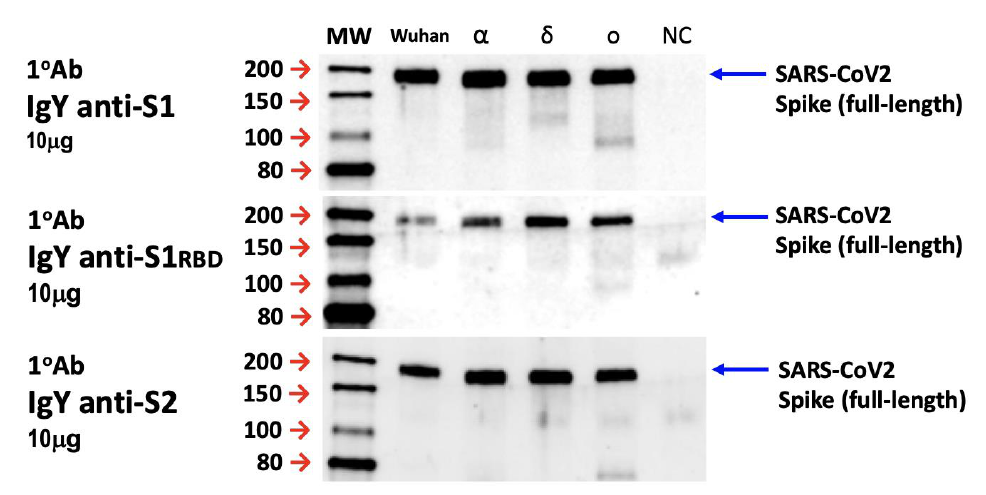
Figure 3. IgYs specific for S1, S1-RBD, or S2 subunits of SARS-CoV-2 (S) spike protein interact specifically with full-length spike proteins. The Vero E6 cells infected with indicated strain of SARS-CoV-2 (i.e., the Wuhan, Alpha, Delta, and Omicron strains) were harvested and protein lysates were collected. Then, 10 µ g/mL of egg yolk IgYs specific for S1, S1-RBD, or S2 subunits were used as the primary antibodies to immuno-react with the protein lysates from SARS-CoV-2-infected Vero E6 cells. The specificity and immunoreactivity of the purified IgY products to spike proteins of different SARS-CoV-2 strains within the cell lysates are demonstrated.